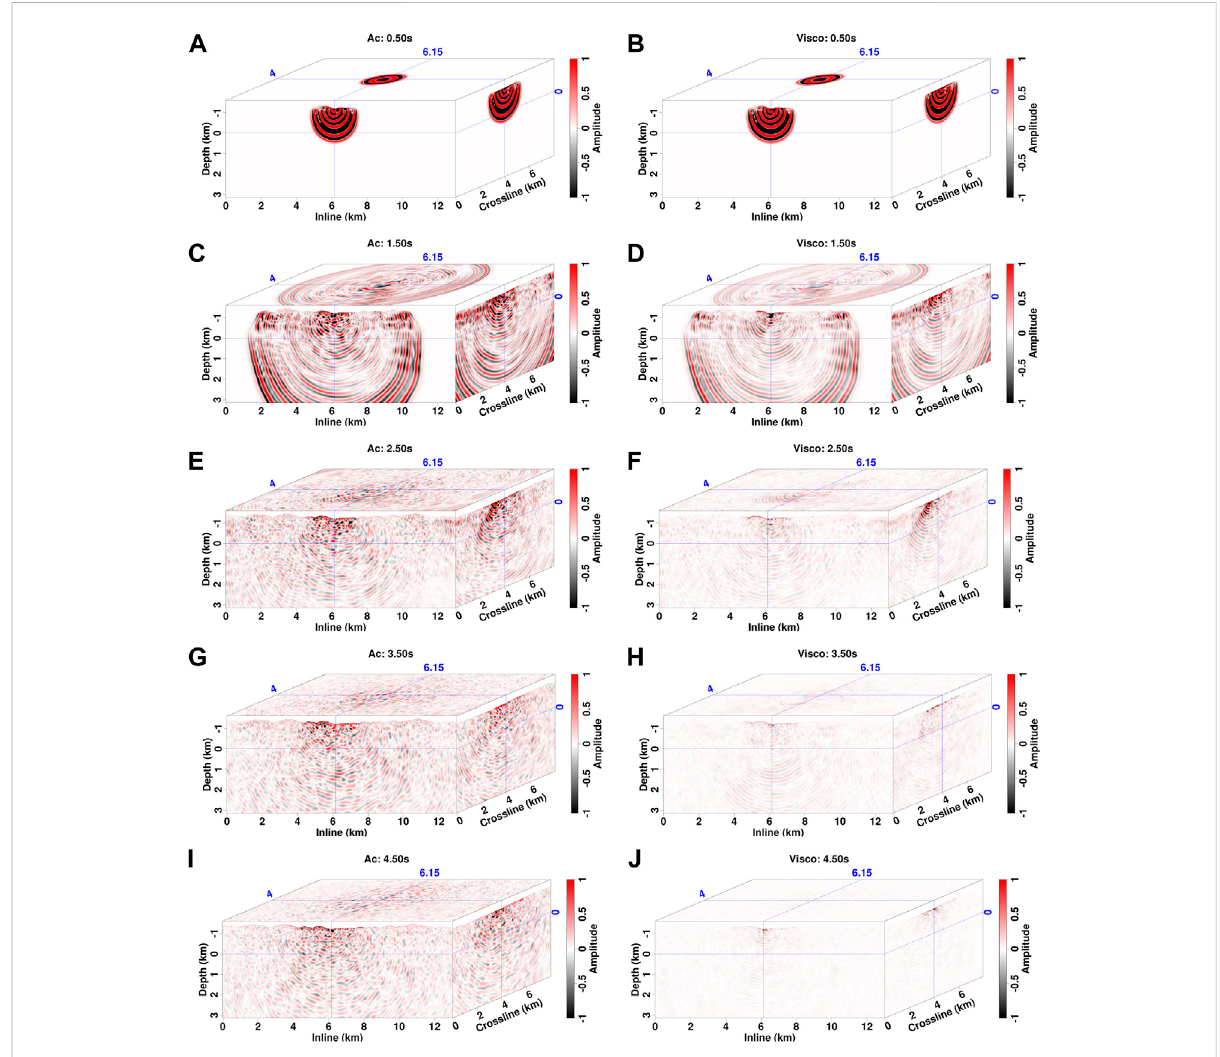
FIGURE 17 Comparison of acoustic (A,C,E,G,I) and viscoacoustic (B,D,F,H,J) wave fi elds with the source location at the ditch (No. 1 in Figure